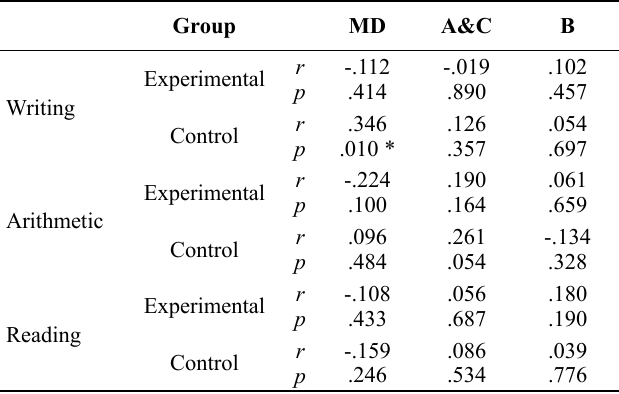
Table 5: Correlation ( r ) between motor and school performance in the experimental and control